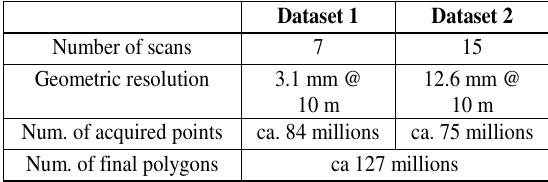
Figure 1. The position of the archaeological area in Aquileia close to the ancient city walls.